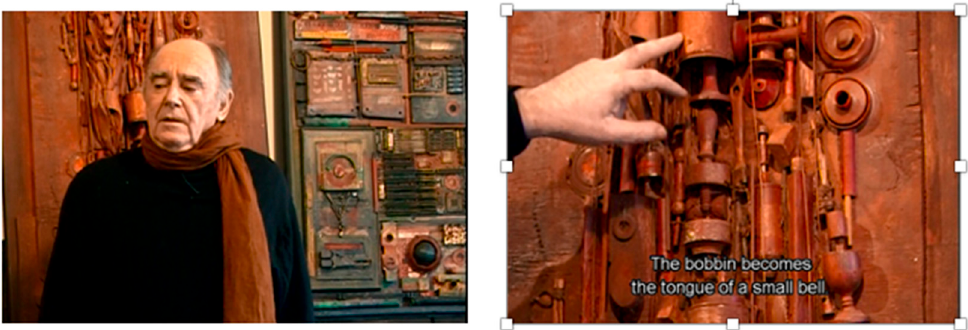
Figure 10. The artist Louis Pons explains the artistic potential for transformation in everyday waste.